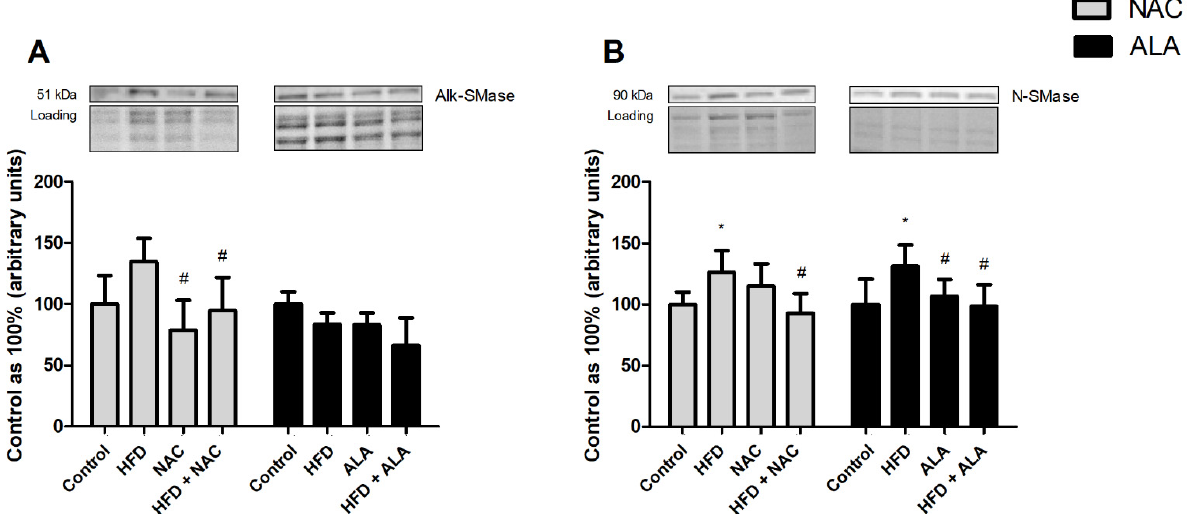
Figure 5. The total expression of proteins from the sphingomyelinase pathway, i.e., ( A ) alkaline sphingomyelinase (Alk-SMase), ( B ) neutral sphingomyelinase (N-SMase) after eight-week treatment of n-acetylcysteine (NAC) or α -lipoic acid (ALA) in the left ventricle of rats fed a standard diet (Control group) or high-fat diet (HFD group). The data are expressed as the mean values ± SD and are based on six independent determinations ( n = 6). * p < 0.05 significant difference vs. corresponding Control group; # p < 0.05 significant difference vs. corresponding high-fat diet group.